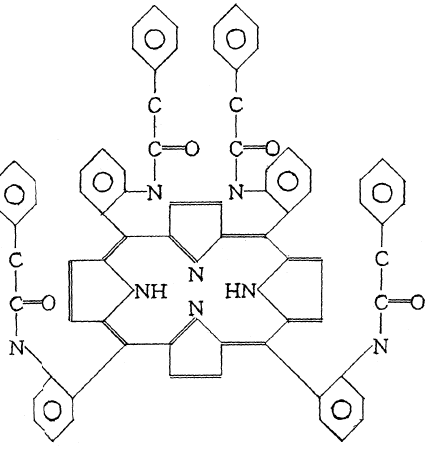
Figure 1. The structure of meso- tetra( a , a , a , a - o -phenylacetamidophenyl)porphyrin as complete